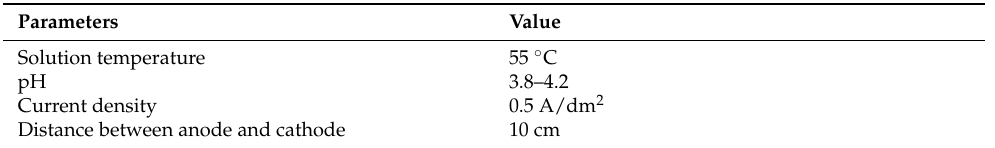
Table 4. The selected parameter combination for gold electroplating. Parameters